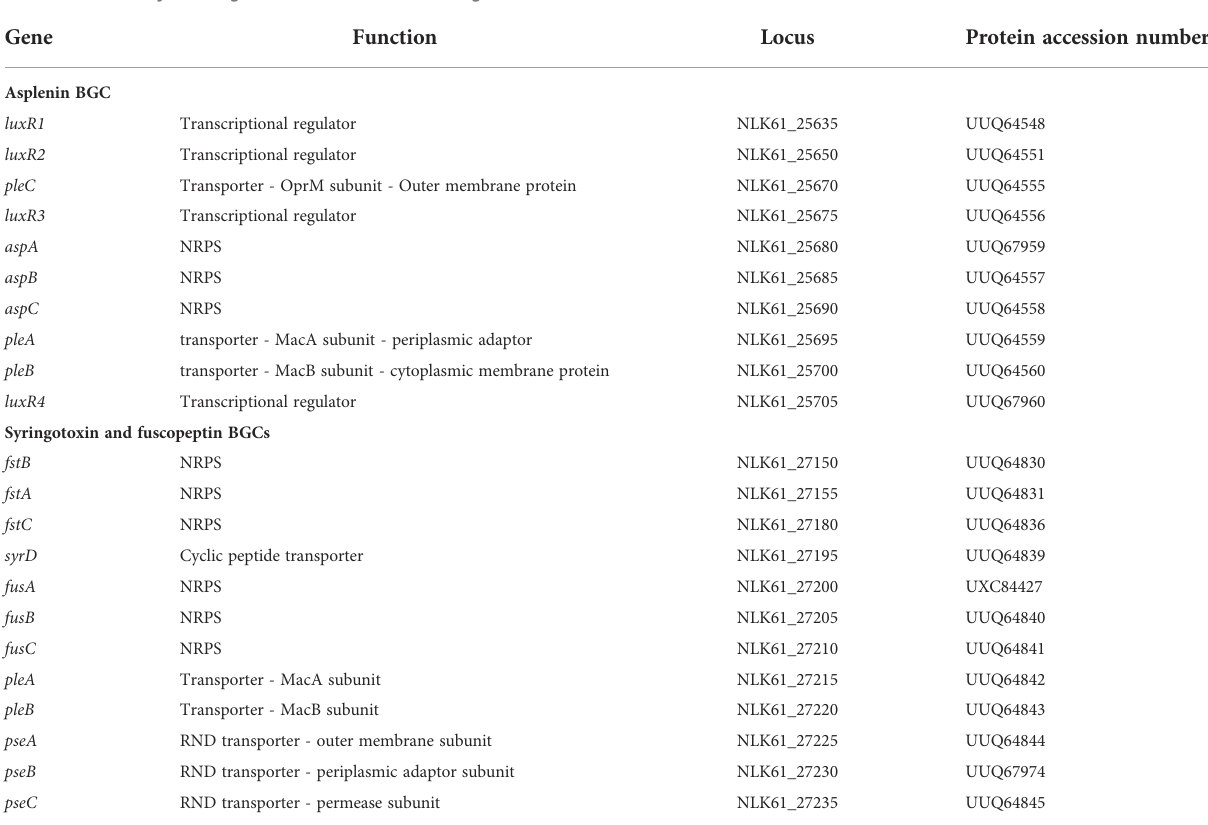
TABLE 2 CLP biosynthetic gene clusters and associated genes.